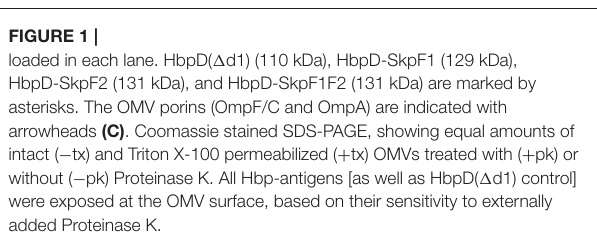
FIGURE 1 | loaded in each lane. HbpD( 1 d1) (110 kDa), HbpD-SkpF1 (129 kDa), HbpD-SkpF2 (131 kDa), and HbpD-SkpF1F2 (131 kDa) are marked by asterisks. The OMV porins (OmpF/C and OmpA) are indicated with arrowheads (C) . Coomassie stained SDS-PAGE, showing equal amounts of intact ( − tx) and Triton X-100 permeabilized ( + tx) OMVs treated with ( + pk) or without ( − pk) Proteinase K. All Hbp-antigens [as well as HbpD( 1 d1) control] were exposed at the OMV surface, based on their sensitivity to externally added Proteinase